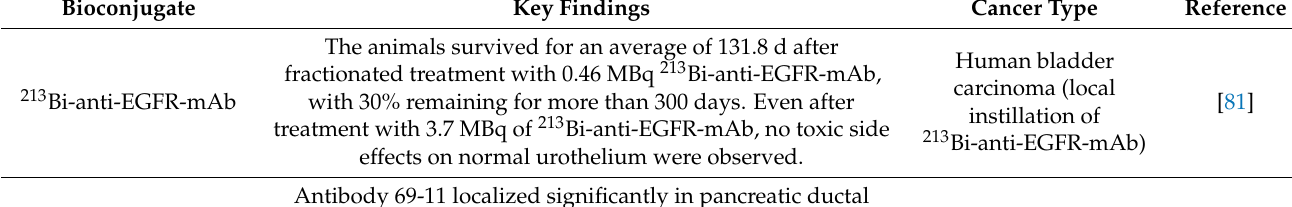
Table 3. Overview of some preclinical studies with 213